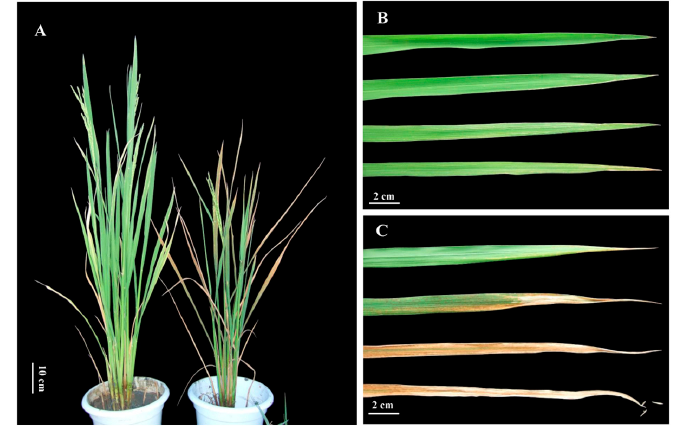
Figure 7. Comparisons of plant morphological phenotypes ( A ) between esl mutant ( right ) and its corresponding wild-type cultivar ( left ) at the heading stage. The flag leaves of esl mutant ( B ) and wild-type cultivar ( C ) sampled over 8-day intervals from anthesis to 24 days after anthesis.